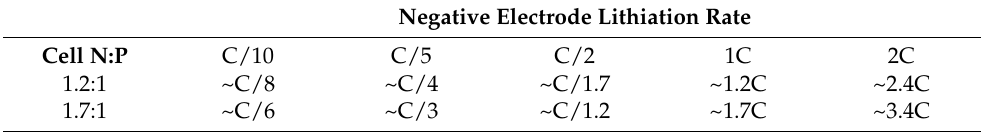
Table 2. Equivalent area positive electrode rate observed for charging sequence based off graphite lithiation limits. C-rates are determined based off 150 mAh g − 1 and 300 mAh g − 1 for NMC and MBMC,